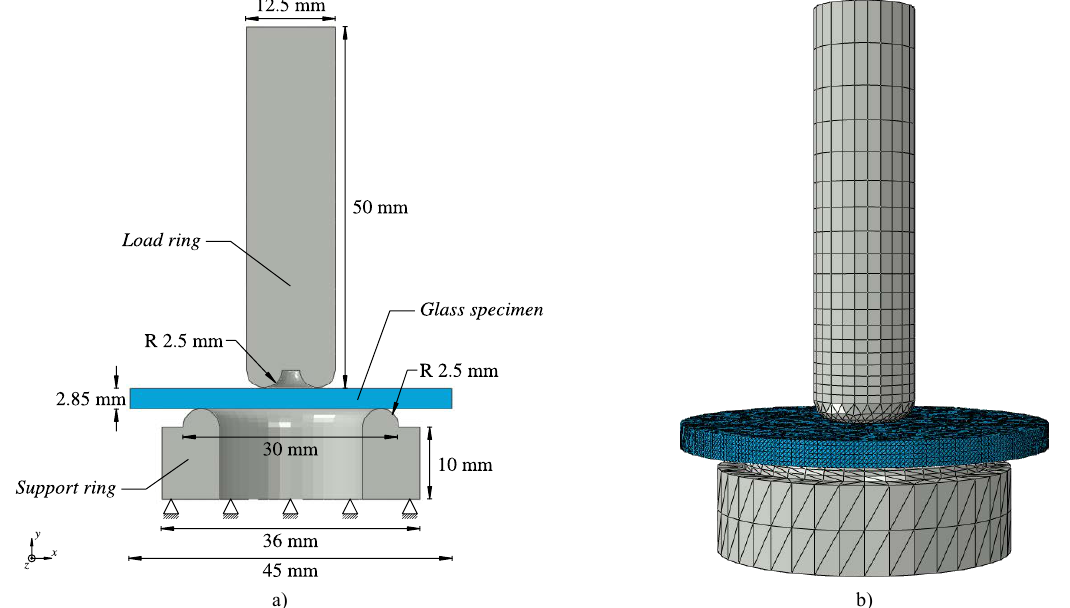
Fig. 6 Numerical model of the ring-on-ring test setup with boundary conditions and dimensions shown in a) and the applied mesh in